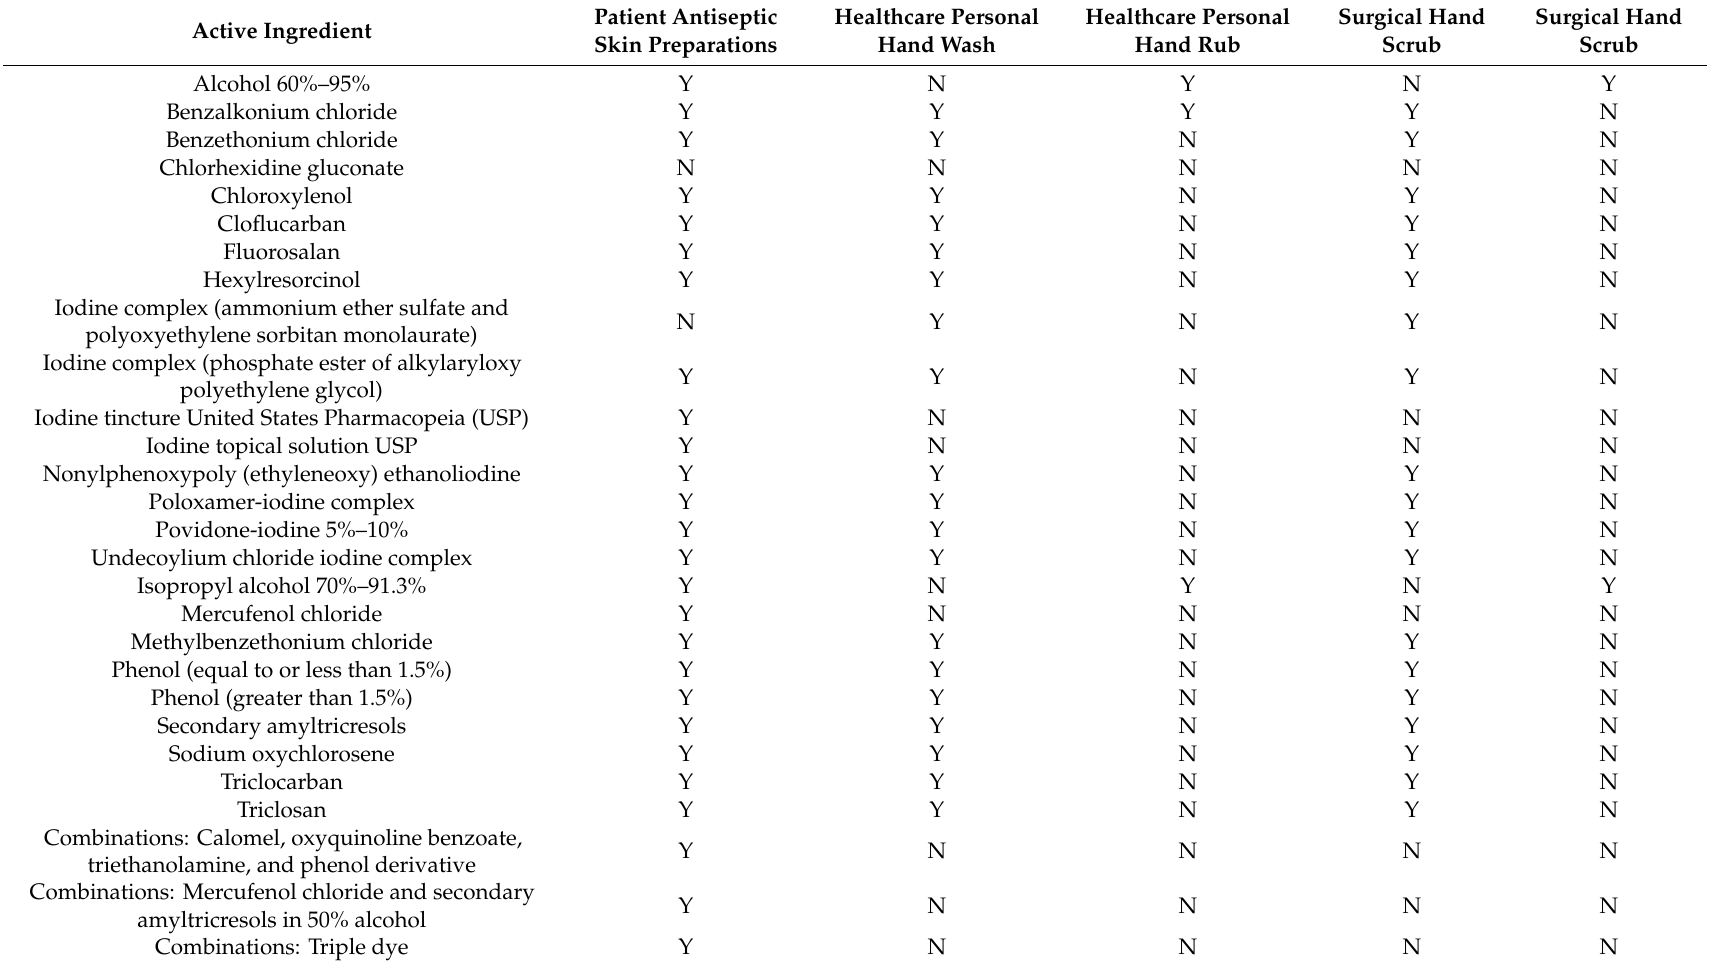
Table 2. List of hand antiseptic ingredients approved by the Food and Drug Administration (FDA) used in healthcare and over the counter (OTC) [30]. Patient Antiseptic Healthcare Personal Healthcare Personal Surgical Hand Surgical Hand Active Ingredient Skin Preparations Hand Wash Hand Rub Scrub Scrub Alcohol 60%–95% Y N Y N Y Benzalkonium chloride Y Y Y Y N Benzethonium chloride Y Y N Y N Chlorhexidine gluconate N N N N N Chloroxylenol Y Y N Y N Cloflucarban Y Y N Y N Fluorosalan Y Y N Y N Hexylresorcinol Y Y N Y N Iodine complex (ammonium ether sulfate and N Y N Y N polyoxyethylene sorbitan monolaurate) Iodine complex (phosphate ester of alkylaryloxy Y Y N Y N polyethylene glycol) Iodine tincture United States Pharmacopeia (USP) Y N N N N Iodine topical solution USP Y N N N N Nonylphenoxypoly (ethyleneoxy) ethanoliodine Y Y N Y N Poloxamer-iodine complex Y Y N Y N Povidone-iodine 5%–10% Y Y N Y N Undecoylium chloride iodine complex Y Y N Y N Isopropyl alcohol 70%–91.3% Y N Y N Y Mercufenol chloride Y N N N N Methylbenzethonium chloride Y Y N Y N Phenol (equal to or less than 1.5%) Y Y N Y N Phenol (greater than 1.5%) Y Y N Y N Secondary amyltricresols Y Y N Y N Sodium oxychlorosene Y Y N Y N Triclocarban Y Y N Y N Triclosan Y Y N Y N Combinations: Calomel, oxyquinoline benzoate, Y N N N N triethanolamine, and phenol derivative Combinations: Mercufenol chloride and secondary Y N N N N amyltricresols in 50% alcohol Combinations: Triple dye Y N N N N Y: Eligible for specified use; N: Ineligible for specified